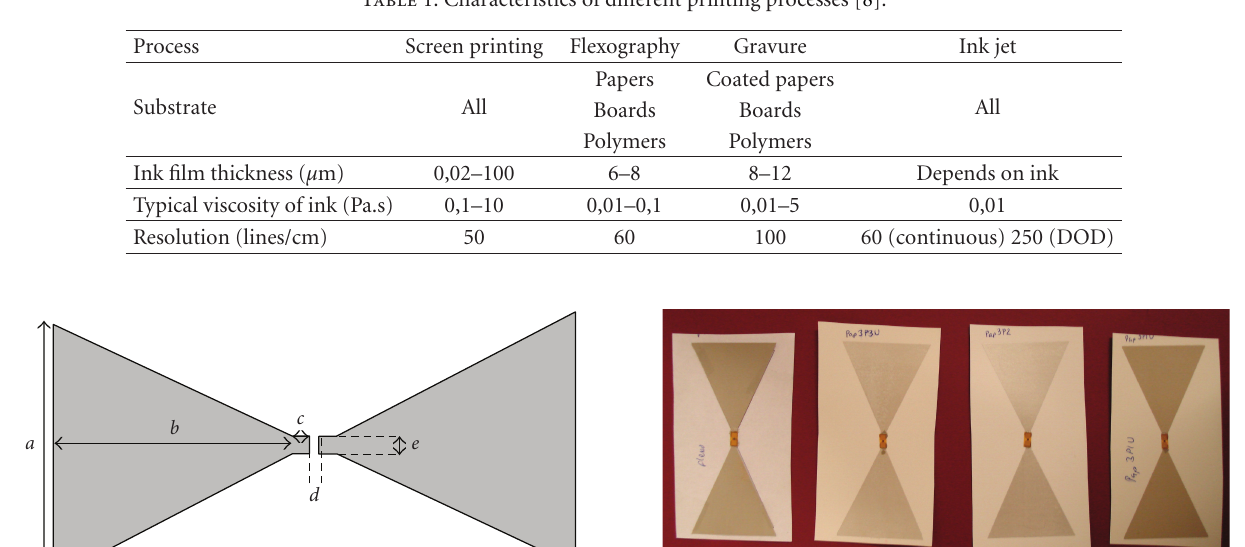
Table 1: Characteristics of di ff erent printing processes [8].